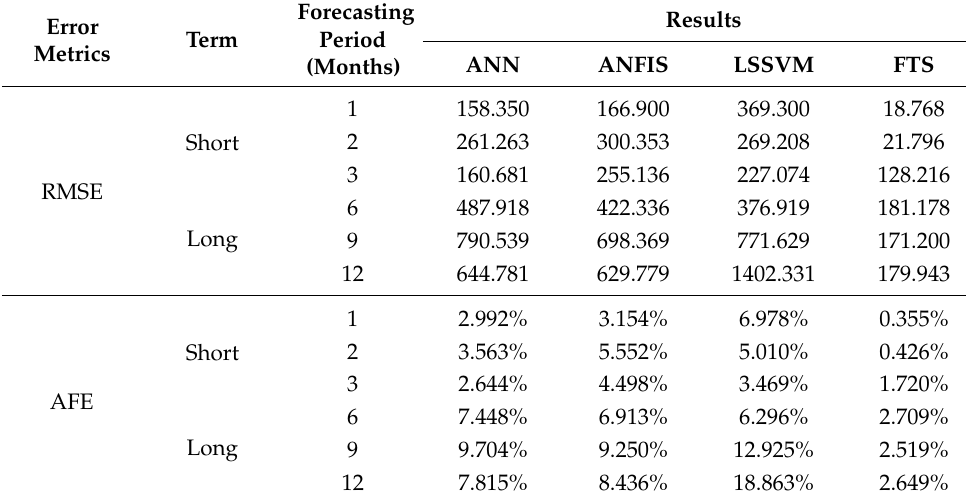
Table 9. Short-term and long-term forecasting results for Algeria.